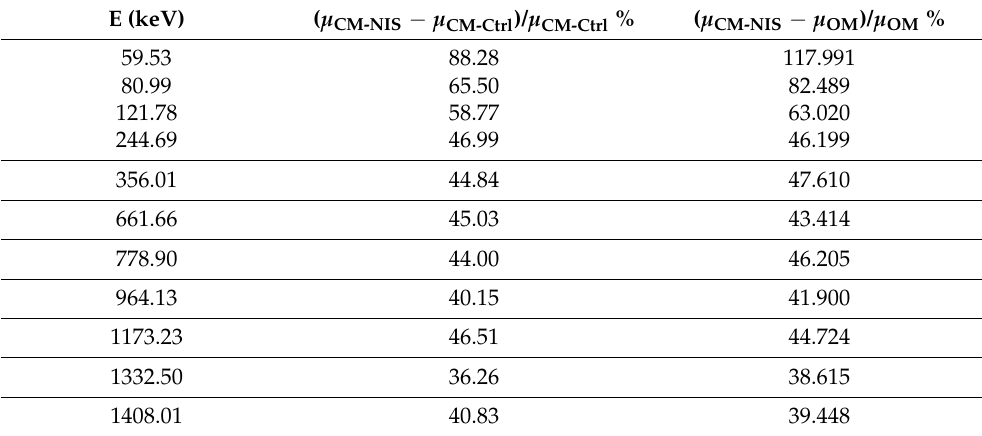
Table 5. The relative rate of increase in the LACs of CM-NIS compared to CM-Ctrl and ordinary mortar (OM).